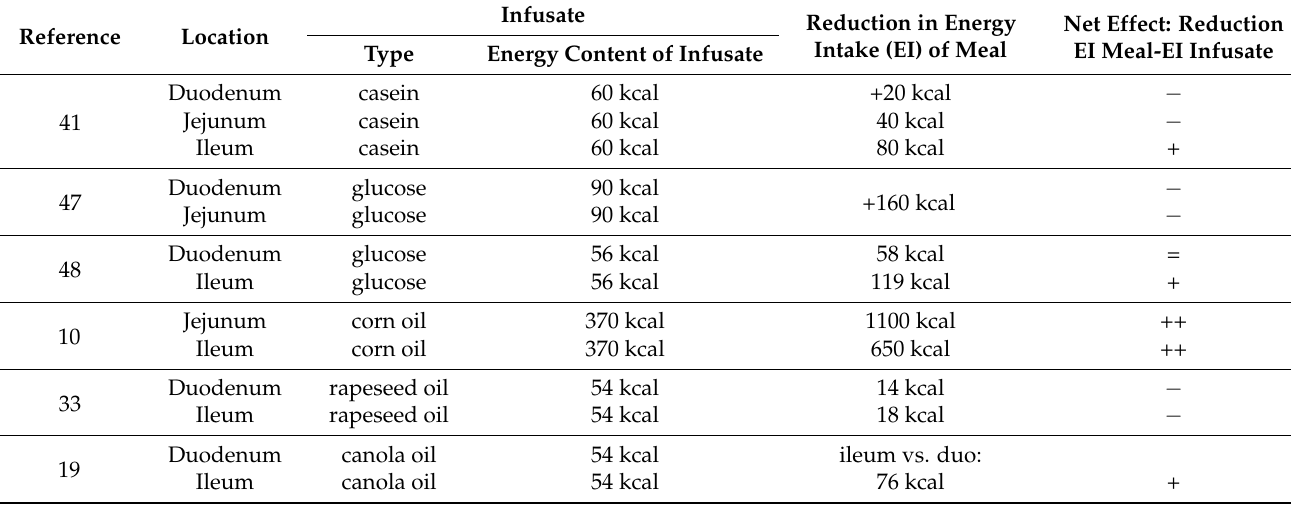
Table 5. Comparison of net effect of energy intake reduction: reduction in energy intake of a meal minus energy content of infusate of fat, proteins or carbohydrates with comparison per location within the same study. Reference